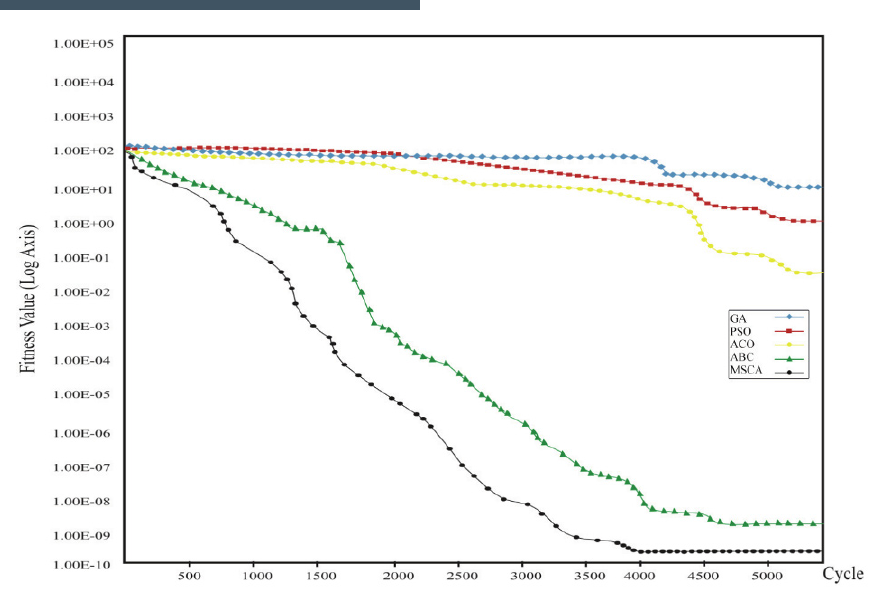
Figure 8. The results of applying different algorithms on Schwefel function.